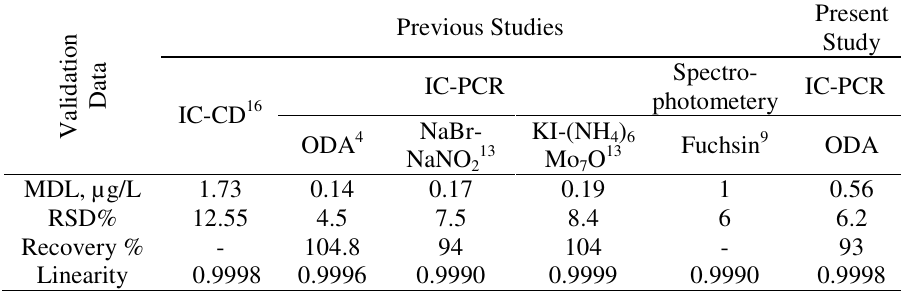
Table 9. Figure of merits of techniques used in bromate